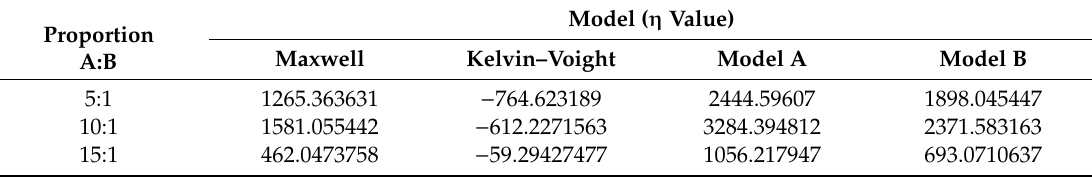
Table 3. η value Mechanical mold derived from the four mechanical